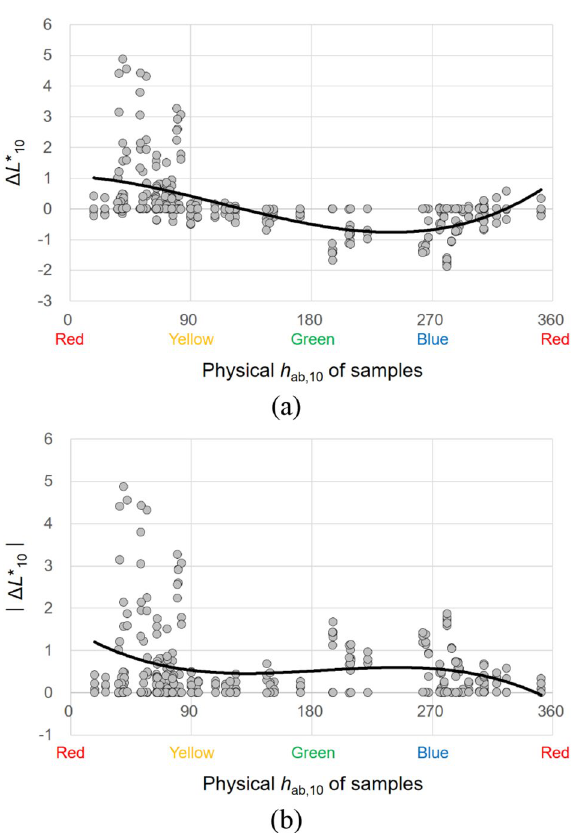
Figure 17. Effect of the physical h ab,10 of samples on their lightness appearance change, ( a ) Δ L * 10 and ( b ) | (cid:31) L ∗ 10 | , under illuminants. (Δ L * 10 = L * A under the illuminant − spectrophotometrically measured L * 10